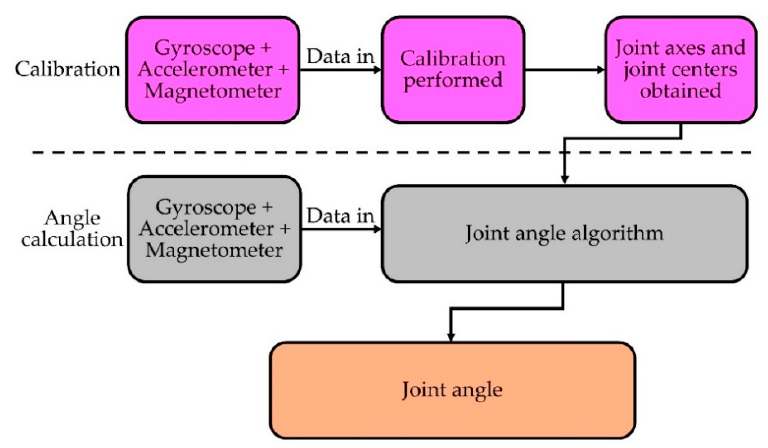
Figure 12. Process flow of joint angle measurement with IMU devices.